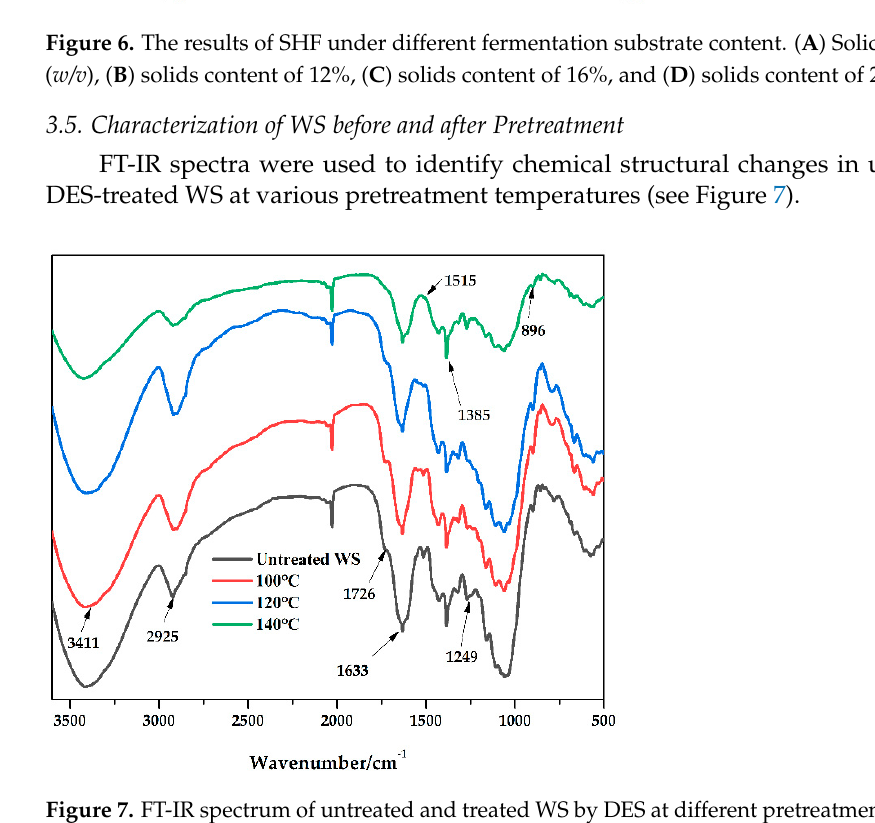
Figure 7. FT-IR spectrum of untreated and treated WS by DES at different pretreatment tempera- tures.